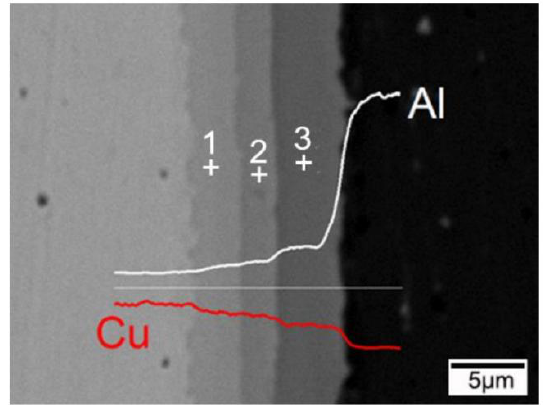
Figure 3. Microstructure (BSE image) of the as-cast Cu/Al clad sheet interface. Table 2. The EDS results of the BSE image in Figure 3.